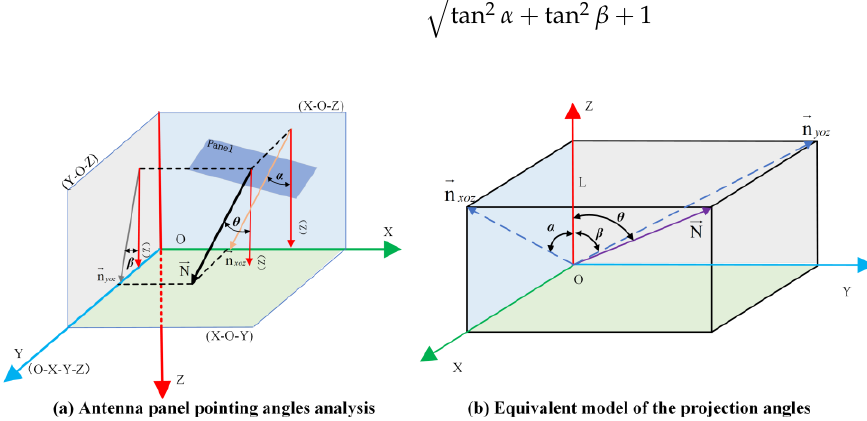
Figure 3. Analysis of antenna’s pointing accuracy.